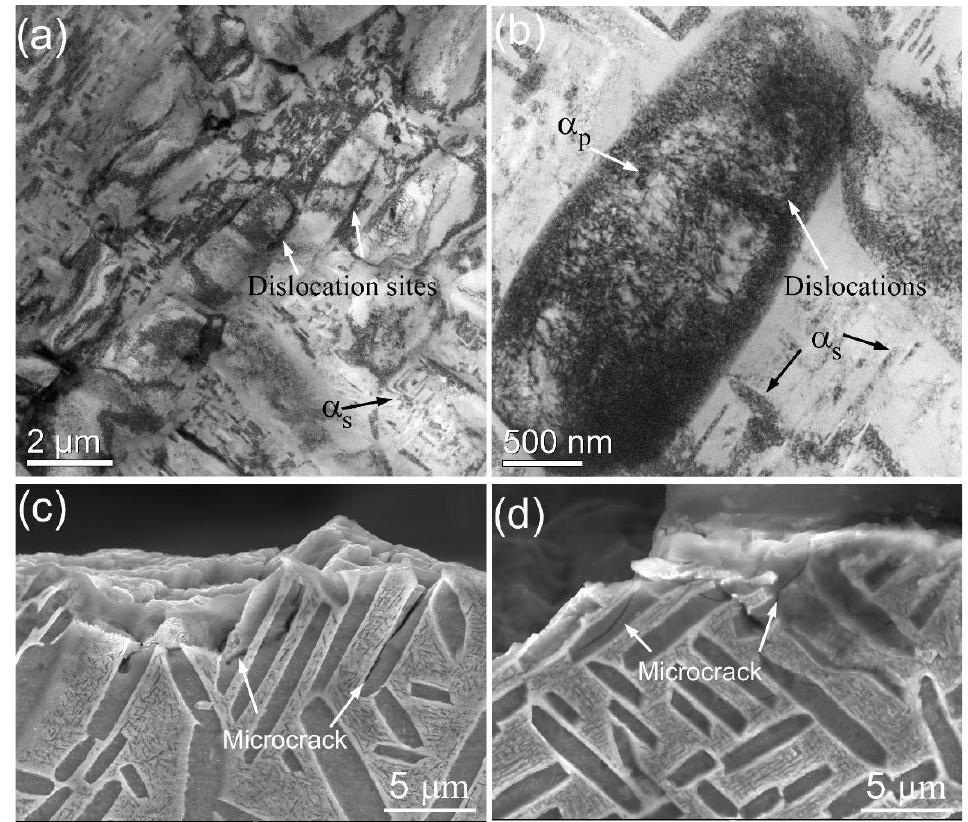
Figure 8. ( a )( b ) TEM images showing the dislocations in the α p and α s phases; ( c ) ( d ) cross-sectional fractographs of the Ti55511 fatigue specimen (loading, 750 MPa; life, 8.29 × 10 6 cycles). To investigate the microscale deformation mechanisms of the Ti55511 alloy under fatigue loading, EBSD was employed to analyze the fatigue specimen (loading, 750 MPa; life, 8.29 × 10 6 cycles). Since the deformation of the Ti55511 alloy was mainly provided by the α p phase under the HCF test process, we only focus on the deformation mechanism of the α p phase in this work. The EBSD results of the AOI are shown in Figure 9. Figure 9a illustrates the orientation maps in the loading direction (Z0). The α p phase was randomly distributed on the β matrix, which was consistent with the OM and SEM results. The EBSD kernel average misorientation (KAM) map is a powerful tool to probe local lattice distor- tion and qualitatively evaluate deformation uniformity. Figure 9b shows the EBSD-KAM map of the Ti55511 HCF specimen. The distinct intensity difference reflected the uneven deformation under the HCF load, which originated from the fact that the α p phases with random orientations exhibited various degrees of deformation. Indeed, the inverse pole figures (IPF), shown in Figure 9c, also displayed the state of random orientation, confirm- ing the absence of a preferred orientation in the AOI region.